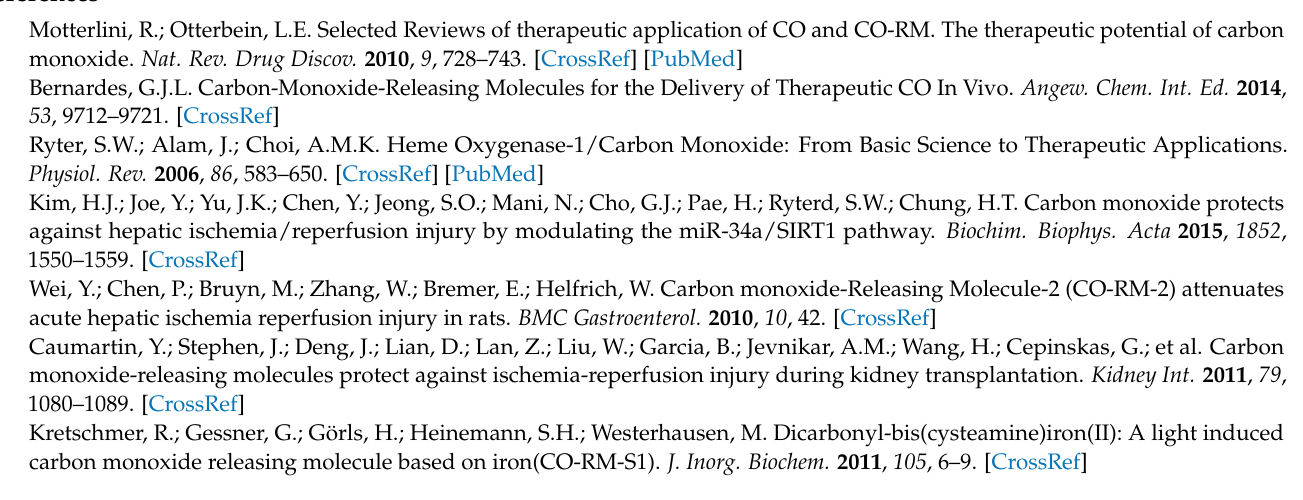
Figure S4: Photo-activated CO release profile for 4 – 15. Table S3: Stand curve measurement and calculation of logP. Figure S5: UV-vis spectrum showing the Q-bands during different concentrations of 4 (left) and Standard curve of 4 (right). Figure S6: UV-vis spectrum showing the Q-bands during different concentrations of 5 (left) and Standard curve of 5 (right). Figure S7: UV-vis spectrum showing the Q-bands during different concentrations of 6 (left) and Standard curve of 6 (right). Figure S8: UV-vis spectrum showing the Q-bands during different concentrations of 7 (left) and Standard curve of 7 (right). Figure S9: UV-vis spectrum showing the Q-bands during different concentra-tions of 8 (left) and Standard curve of 8 (right). Figure S10: UV-vis spectrum showing the Q-bands during different concentrations of 9 (left) and Standard curve of 9 (right). Figure S11: UV-vis spectrum showing the Q-bands during different concentrations of 10 (left) and Standard curve of 10 (right). Figure S12: UV-vis spectrum showing the Q-bands during different concen-trations of 11 (left) and Standard curve of 11 (right). Figure S13: UV-vis spectrum showing the Q-bands during different concentrations of 12 (left) and Standard curve of 12 (right). Figure S14: UV-vis spectrum showing the Q-bands during different concentrations of 13 (left) and Standard curve of 13 (right). Figure S15: RAW264.7 cell changes inhibited by 4 (dark: a-50 µ M; b-500 µ M, illumination: c-50 µ M; d-500 µ M). Figure S16: HT29 cell changes inhibited by 4 (dark: a-50 µ M; b-500 µ M, illumination: c-50 µ M; d-500 µ M). Figure S17: RAW264.7 cell changes inhibited by 8 . Figure S18: HT29 cell changes inhibited by 8 . Figure S19: Cell viability of RAW264.7 cell and HT29 in presence of 8